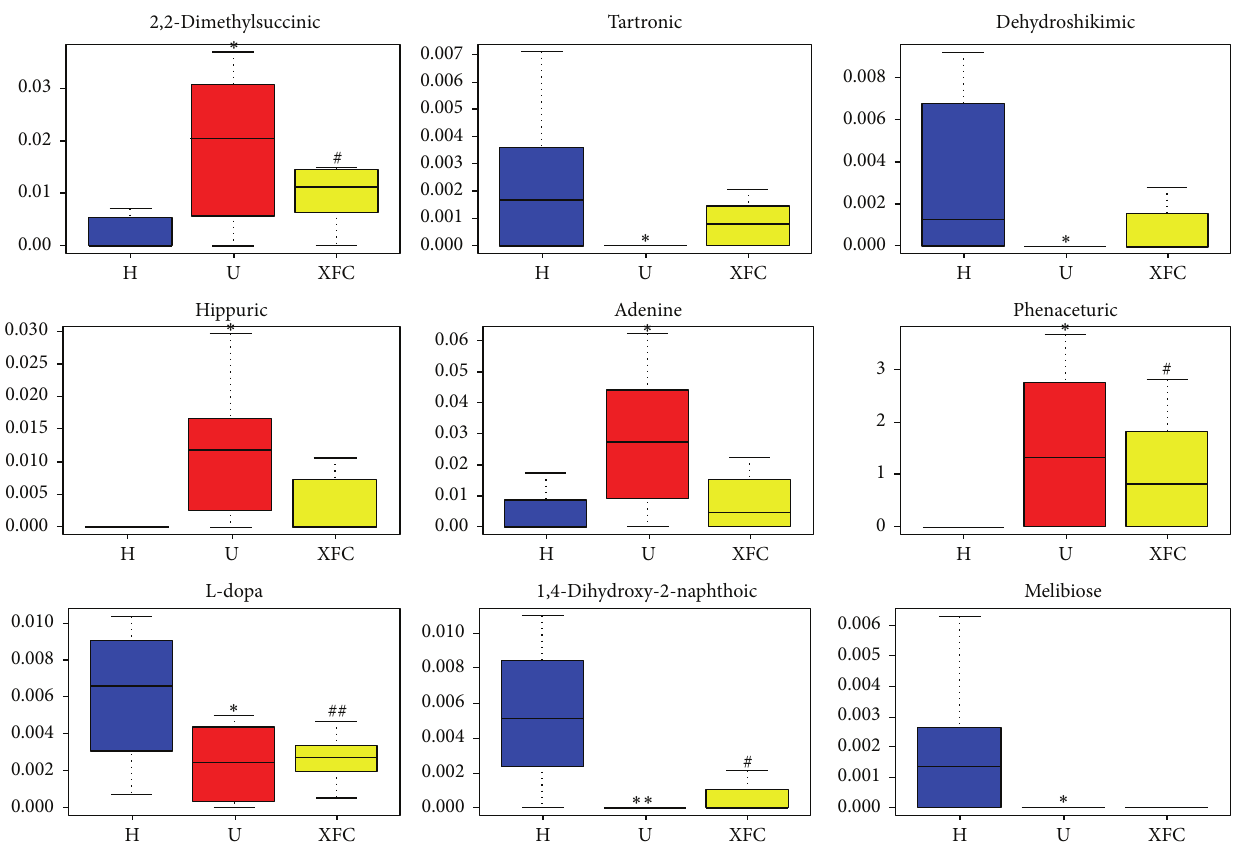
Figure 7: Box plots of data in urine samples from healthy group (H), untreated group (U), and XFC treated group (XFC). ∗ 𝑝 < 0.05 and ∗∗ 𝑝 < 0.01 compared with healthy group; # 𝑝 < 0.05 compared with untreated group; ## 𝑝 < 0.01 compared with untreated